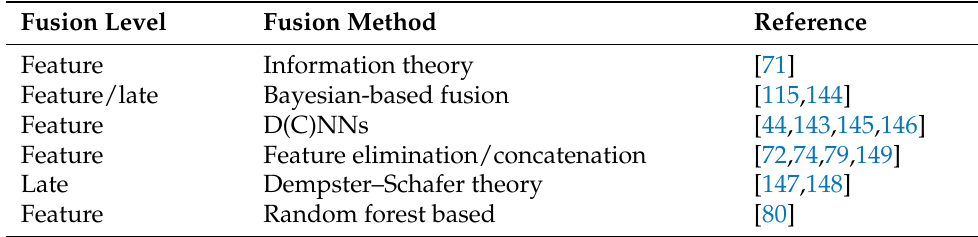
Table 4. Summary of the fusion